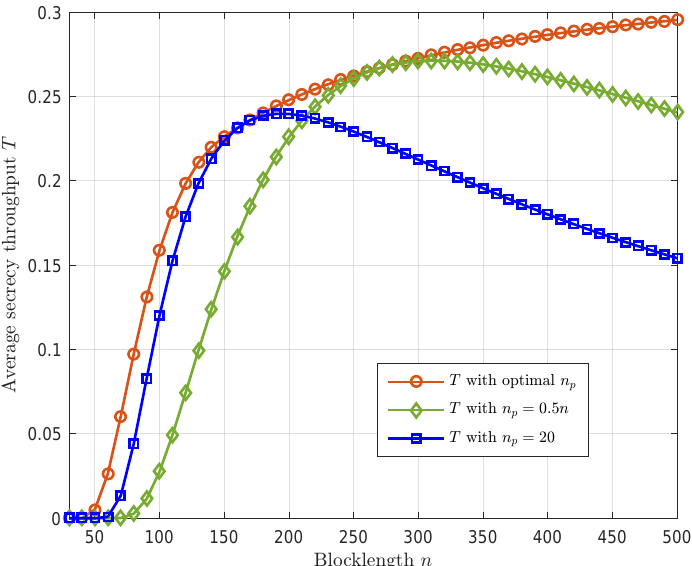
Figure 4. The average secrecy throughput T versus the blocklength n with α = 0.5, ρ = 10 dB, ¯ γ sd = 0 dB, and ¯ γ se = 0 dB, where the optimal channel training length is obtained without reliability